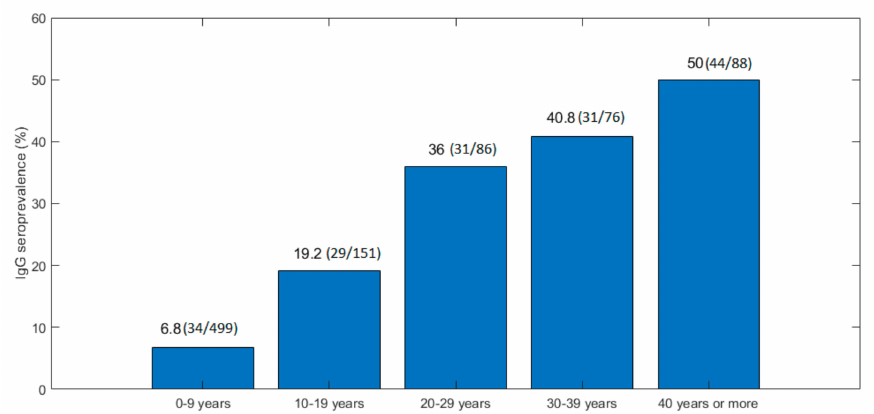
Figure 3. Prevalence of anti-HEV IgG in patients by age